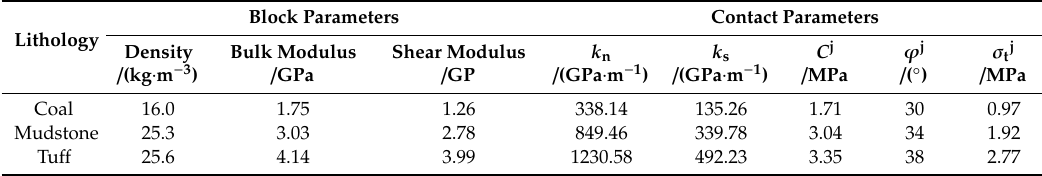
Table 3. Calibrated rock mass mechanical parameters of simulated rock